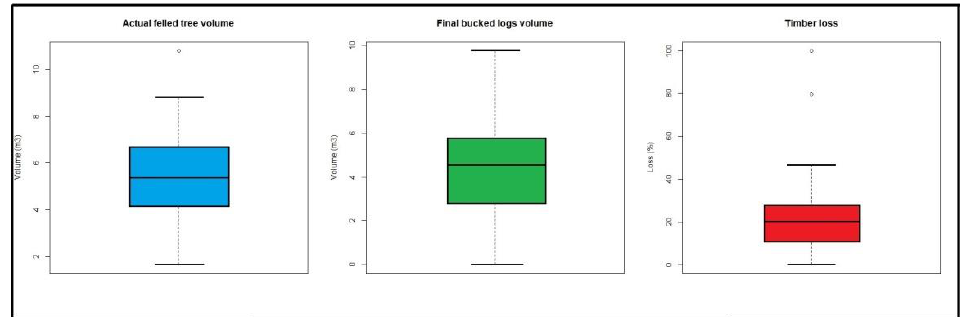
Figure 3. Box plots showing variations in actual felled tree volume, final bucked logs, and timber losses in tree felling stage.